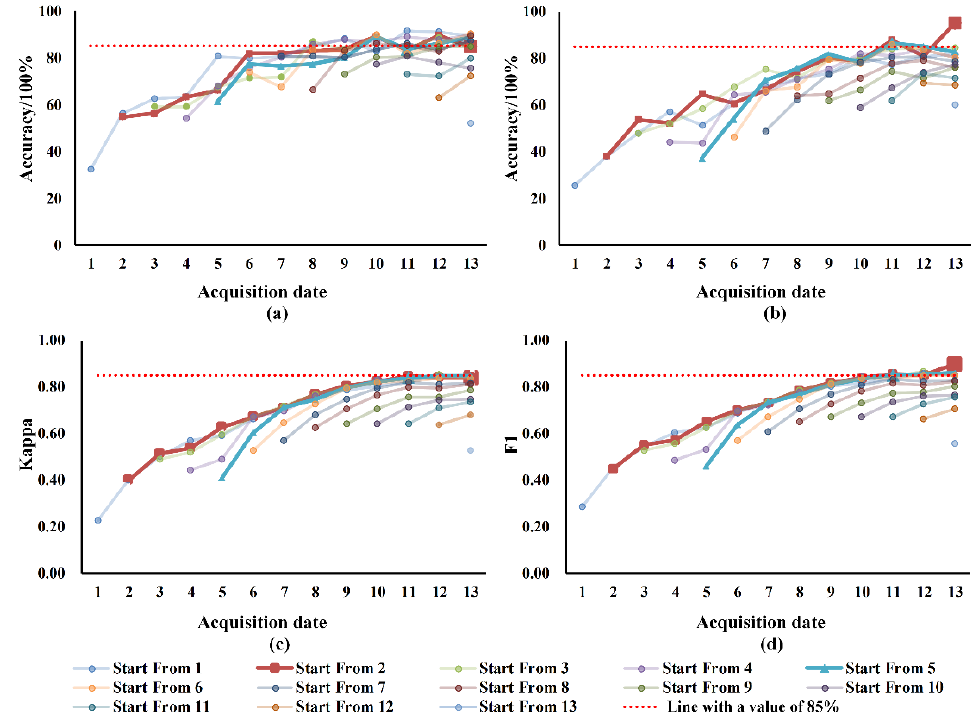
Figure 4. Over time in the reference region, the result accuracy assessments of the U-Net trained on different multi-temporal datasets; ( a – d ) are the classification PA, UA, Kappa, and F1 score over time in the reference region, respectively. Each point reflects the classification results of the model using temporal input till corresponding time steps.